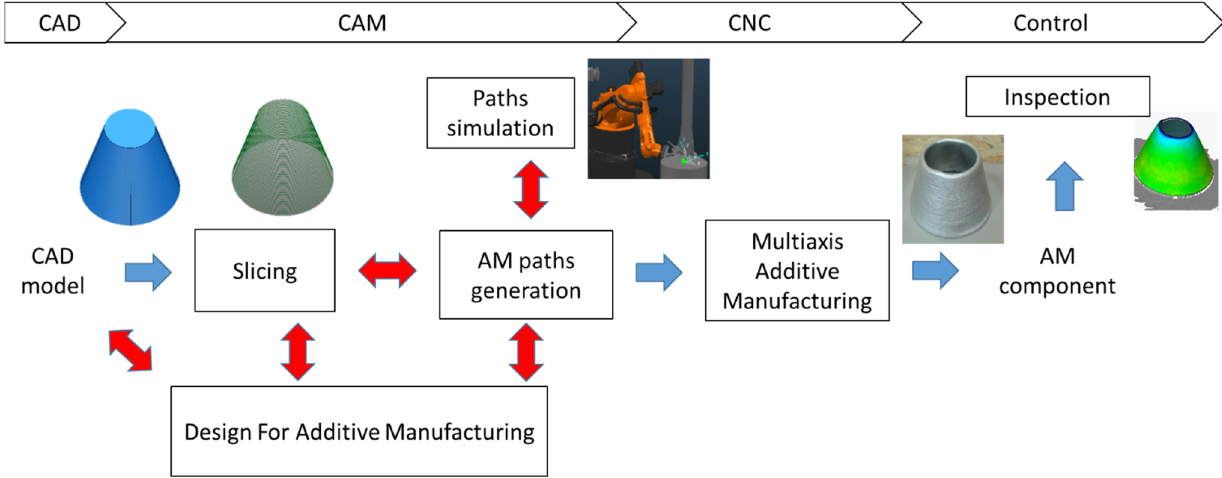
Figure 2. From CAD model to manufactured part with AM.